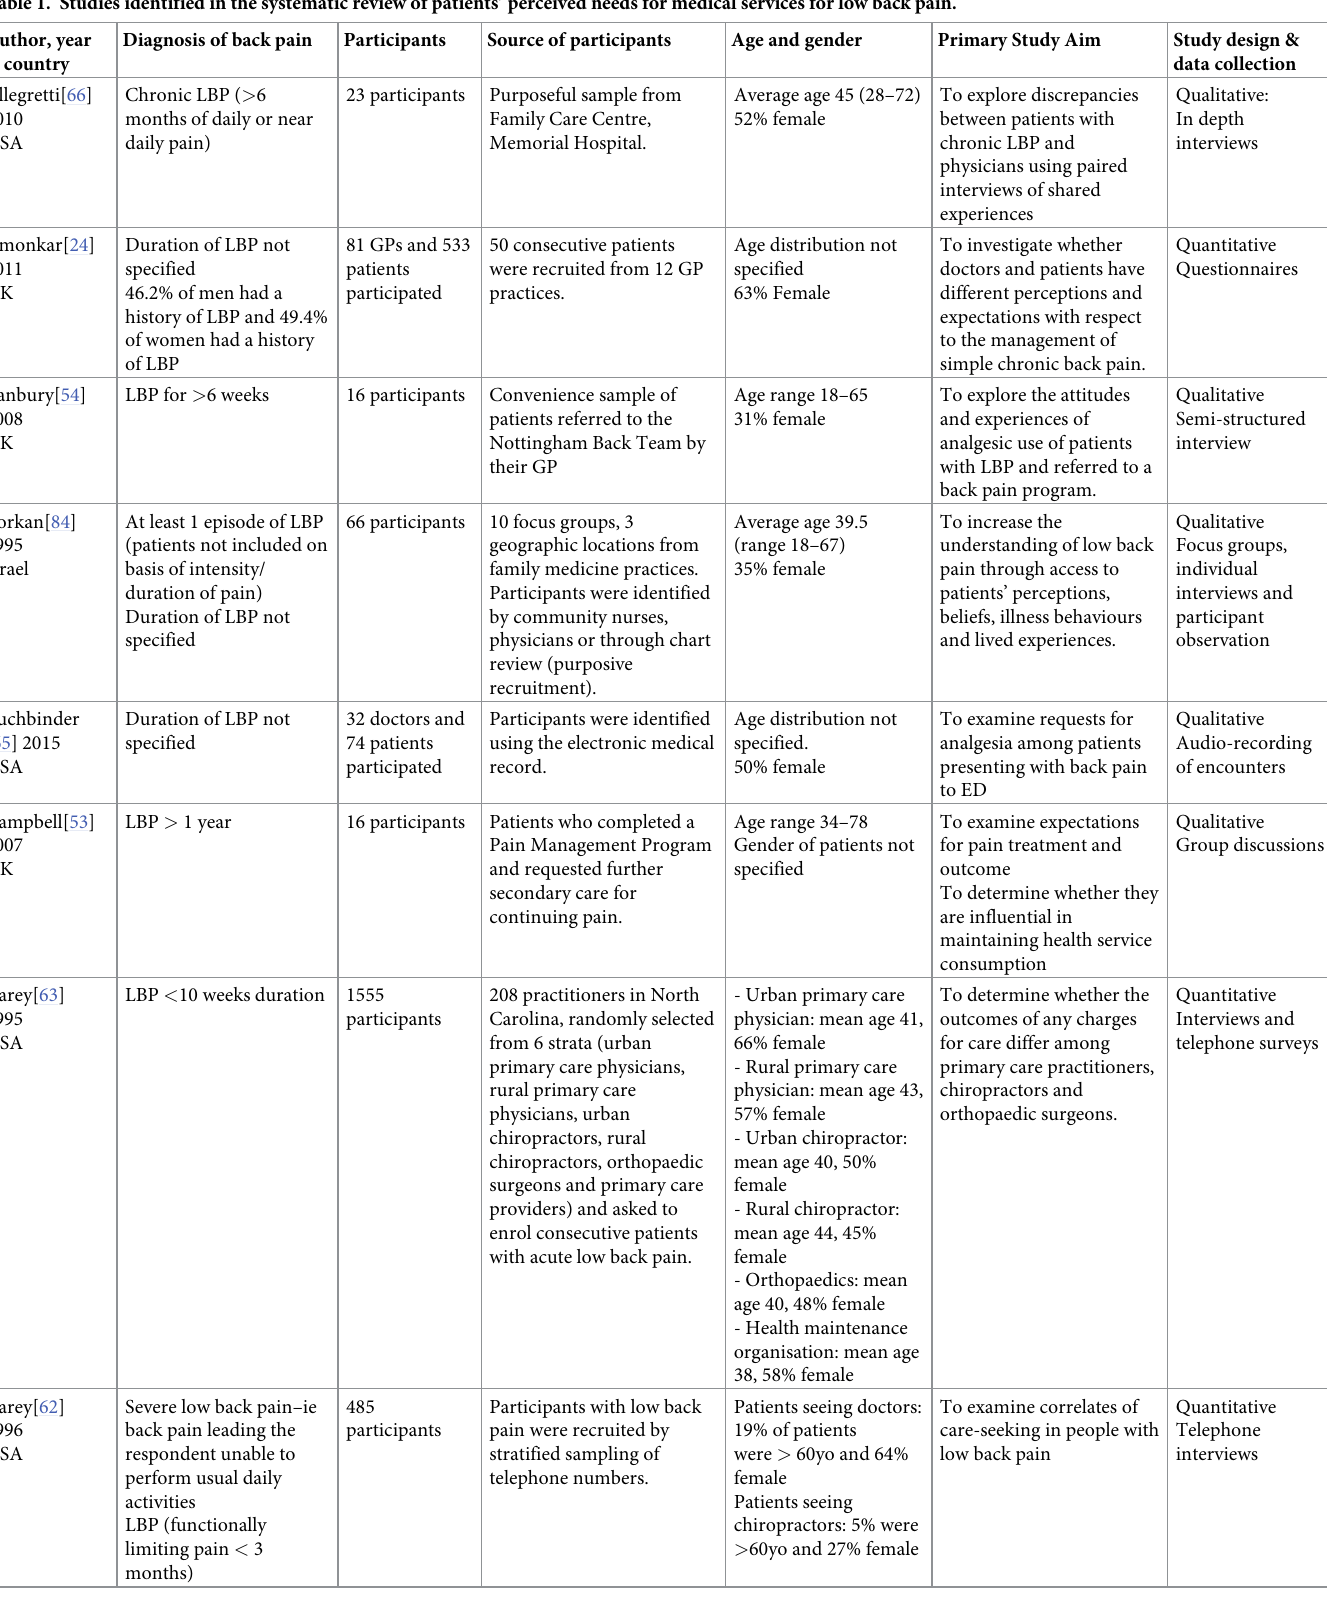
Table 1. Studies identified in the systematic review of patients’ perceived needs for medical services for low back